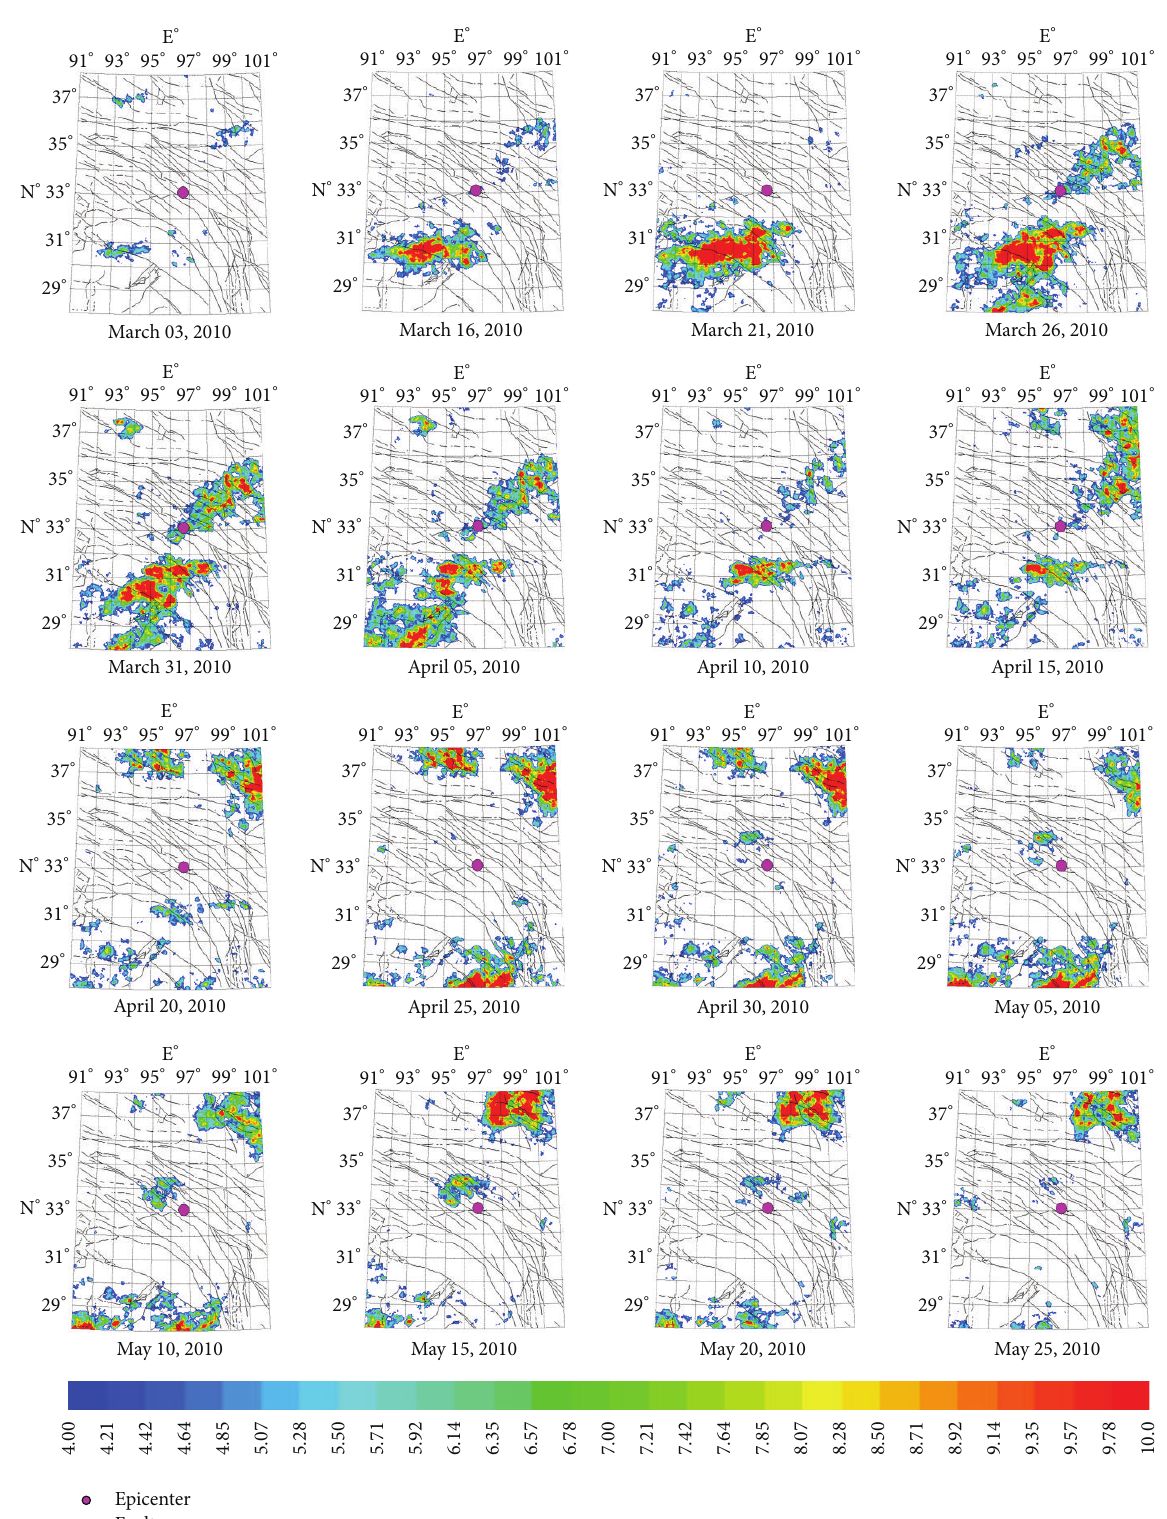
Figure 4: Space-time evolution of Yushu Ms 7.1